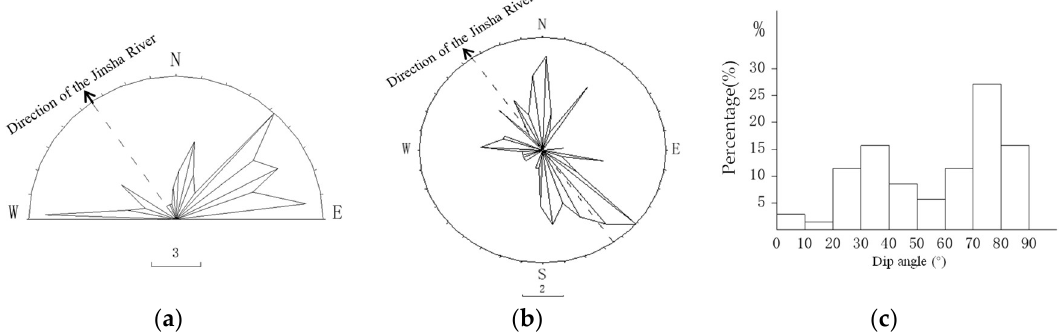
Figure 4. Surface fault statistics in dam site area. ( a ) Rose of the strike; ( b ) rose of dip; ( c ) dip angle histogram.